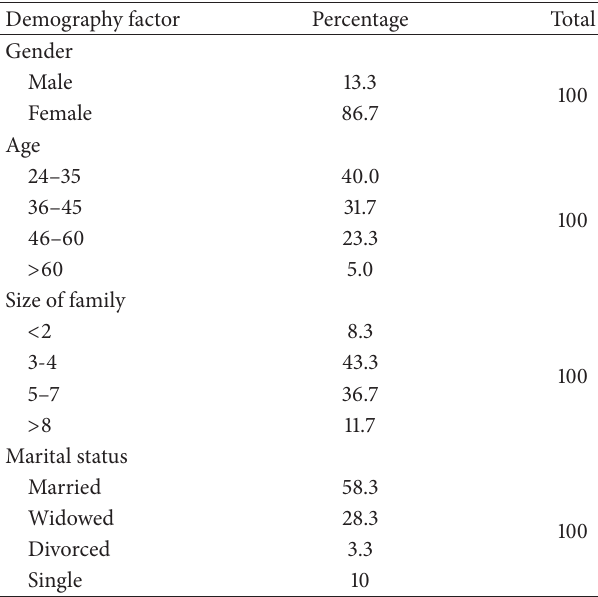
Table 1: Demographic data of Bindura high density residents ( 𝑁 = 60 ).